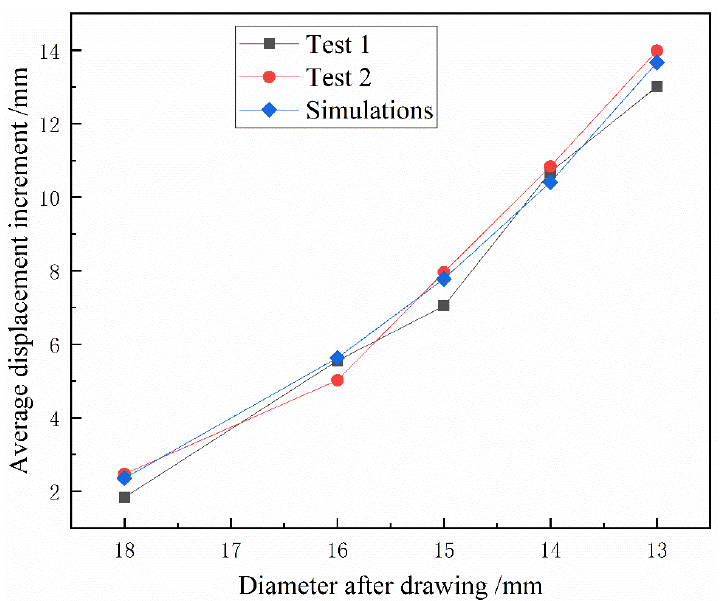
Figure 14. Average axial displacement increments of carbon fibers under different drawing pro- cesses (test 1, test 2 and simulations). (test 1, test 2 and